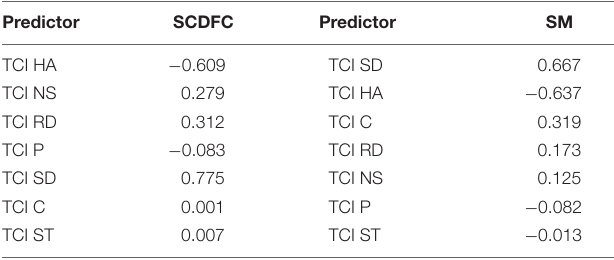
TABLE 3 | Discriminant analysis summary: function coefficients and correlation coefficients.